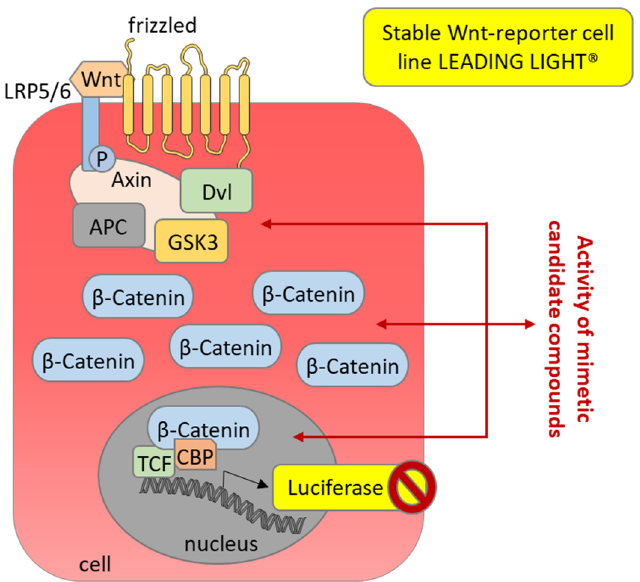
Figure 7. Secondary assay for the primary SFRP1 mimetic hits analyzing activity as Wnt pathway antagonist. The Wnt-reporter cell line LEADING LIGHT ® (Enzo Life Sciences, Farmingdale, NY, USA) expresses luciferase upon stimulation of the Wnt pathway after the addition of recombinant Wnt3a as a Wnt signaling ligand. Candidate SFRP1 mimetic hits might inhibit the Wnt signaling pathway at different levels, which should result in inhibition of the luciferase-induced